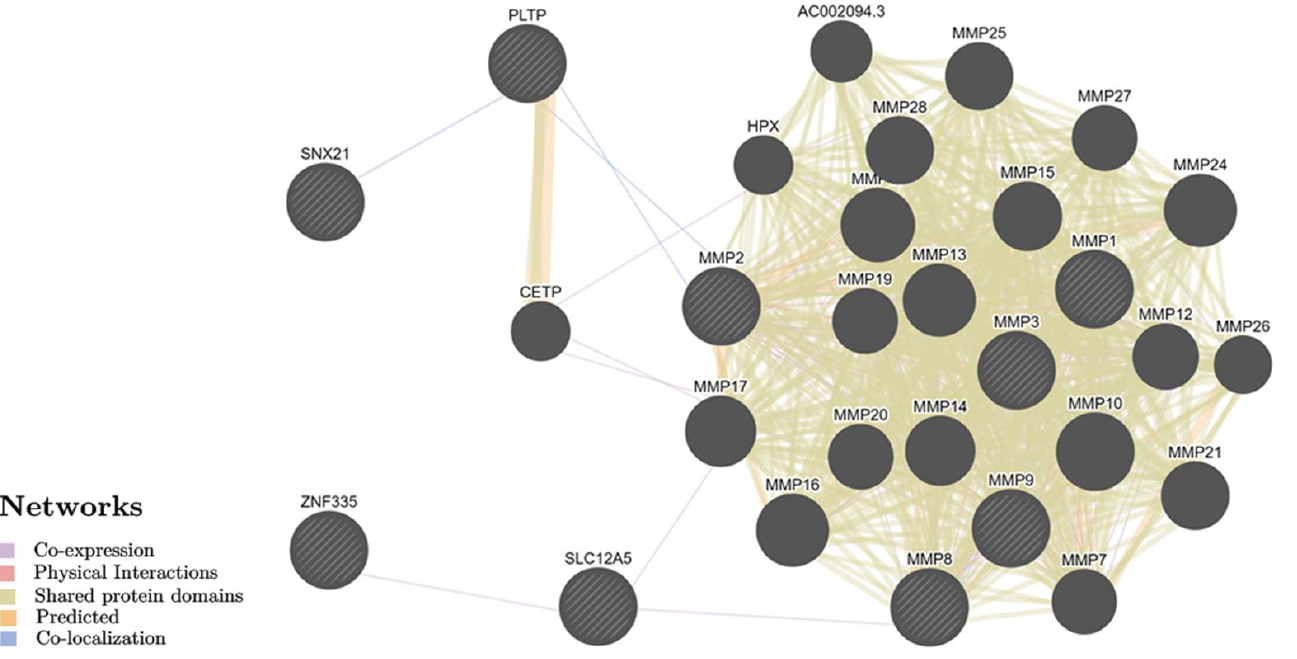
Figure 3. The interaction networks of the breast cancer candidate genes that are functionally significant for breast tissue inferred using GeneMANIA (http://genemania.org, accessed on 18 June 2022). The candidate genes are cross-shaded.